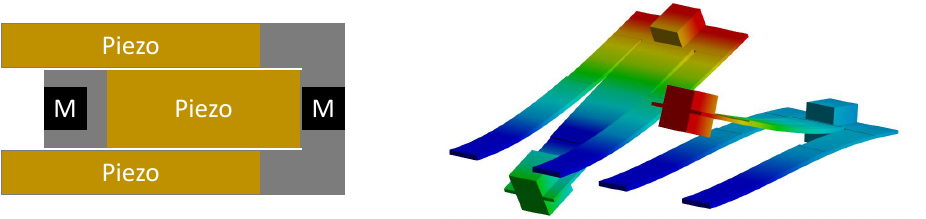
Figure 1. Folded-beam design introduced in [13]. The geometry is shown on the left. It is composed of a steel structure (gray), two tip masses (black), and three piezoelectric patches (mustard). The first two mode shapes of the structure are shown on the